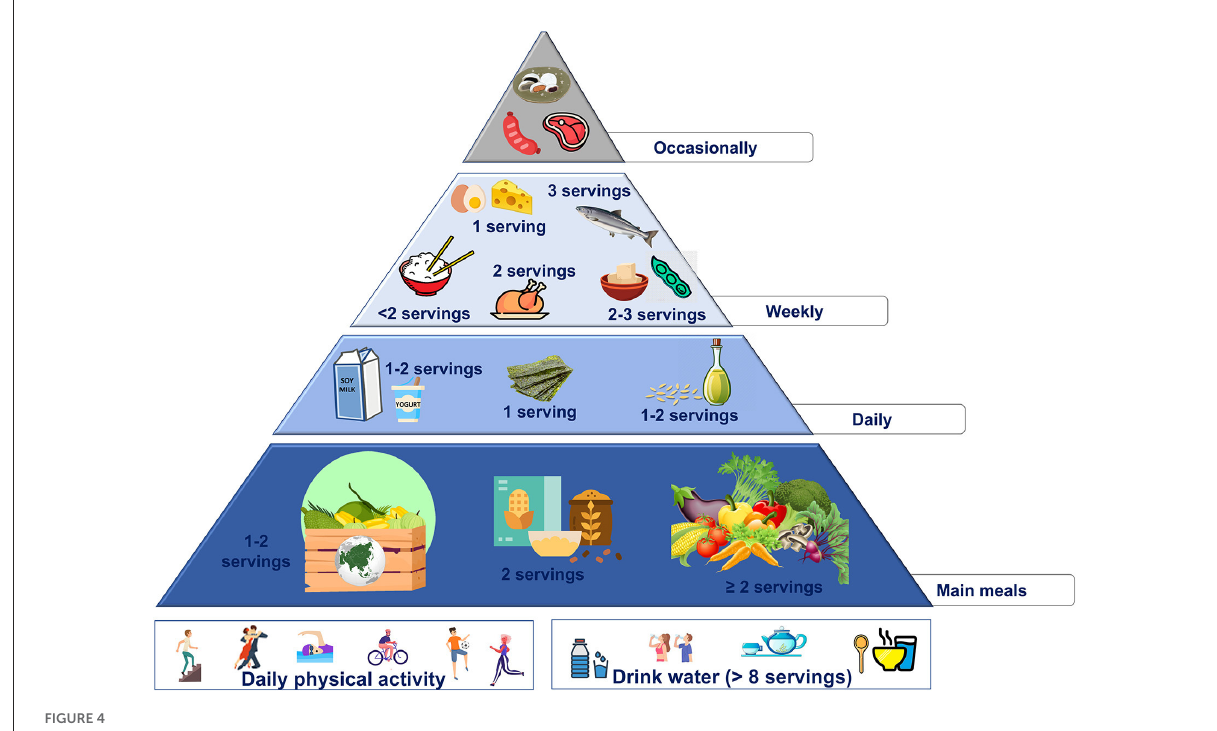
FIGURE4 Proposed nutritional pyramid for Asia.